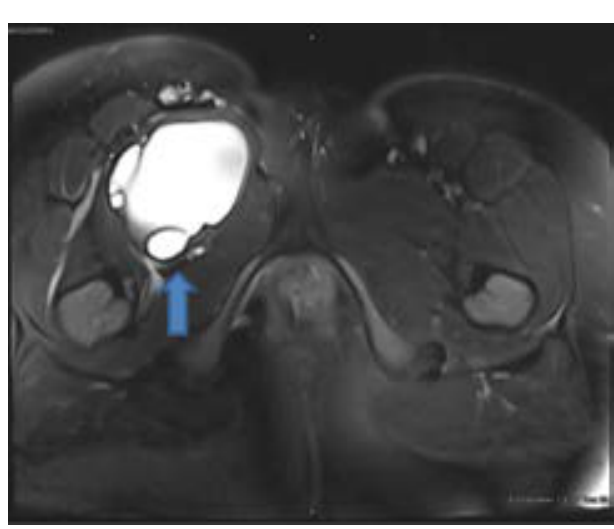
Fig. 3 – MRI image of pelvic iliofemoral hydatid cyst.